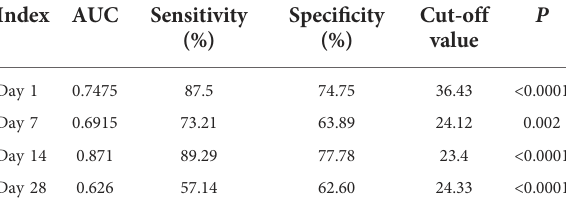
TABLE 2 Diagnostic value of IGF-1 for predicting BPD at different time